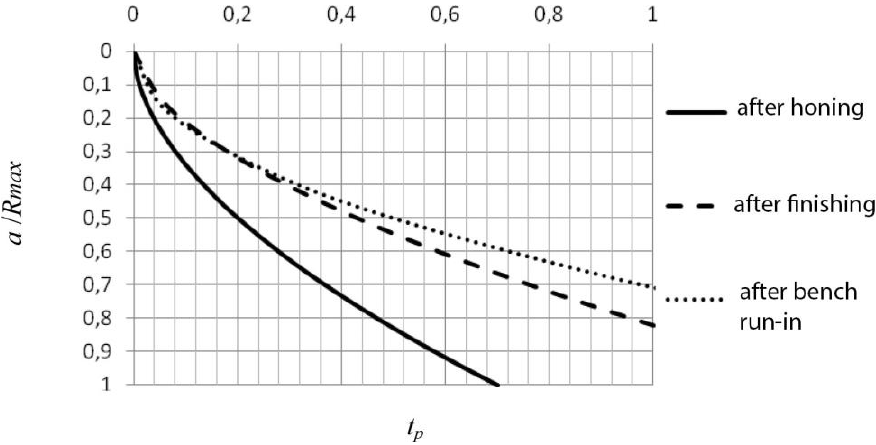
Fig. 1. Estimated values of the initial section of the reference